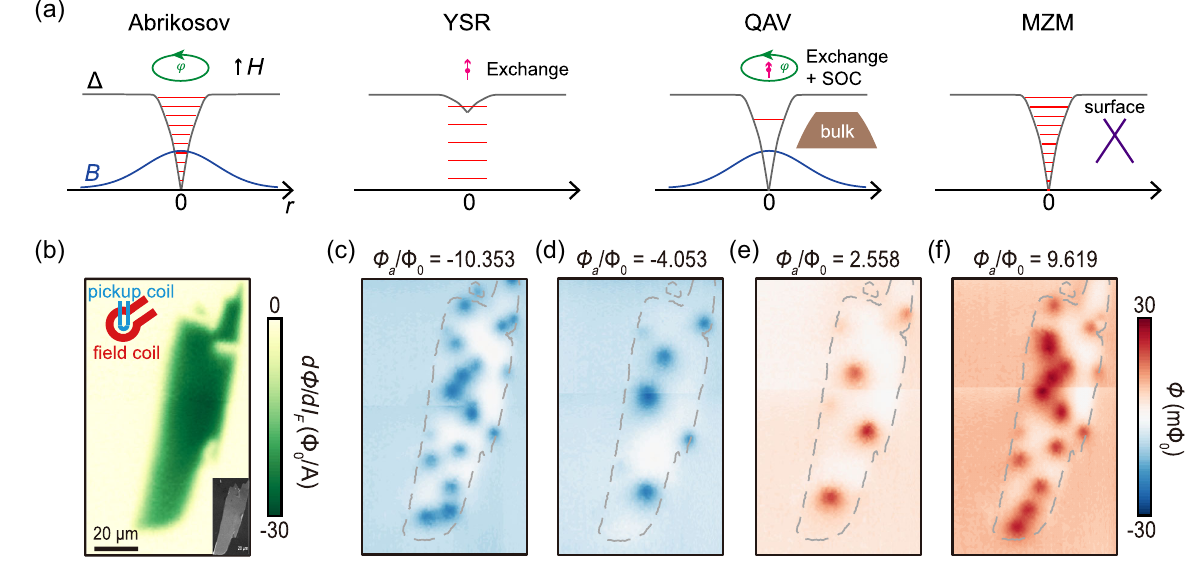
FIG. 1. Abrikosov vortices in an Fe(Se,Te) superconductor imaged by scanning SQUID. (a) Illustration of typical point defects in s -wave superconductors. The defects center at r ¼ 0 . Δ and φ are the amplitude and phase of the superconducting order parameter, respectively, and B is the magnetic induction. Abrikosov: conventional vortex which nucleates with an applied field H ; YSR: Yu-Shiba- Rusinov state, a vortex-free impurity state due to the exchange interaction from the magnetic moment; QAV: quantum anomalous vortex, spontaneous vortex as a result of the exchange interaction from the magnetic impurity and spin-orbit coupling (SOC) from the bulk bands; MZM: Majorana zero mode, a zero-energy charge mode at a vortex core on the Dirac surface states. (b) Susceptometry image of the sample. The dark green area with diamagnetic susceptibility represents the sample, while the white area represents the substrate. The orientation of our SQUID with respect to the sample is illustrated. Inset: scanning electron micrograph of the sample. (c) – (f) Magnetometry images of the sample after field cooling under various applied flux Φ a through the sample. The gray dashed lines outline the boundary of the sample determined from susceptometry. The horizontal discontinuities in the images were a result of stitching two images together. All the images were obtained at 1.5 K. In this regime of j Φ a j > Φ 0 , vortices nucleated with the same vorticity as determined by the sign of Φ a . The amount of observed vortex was clearly larger than j Φ a j = Φ 0